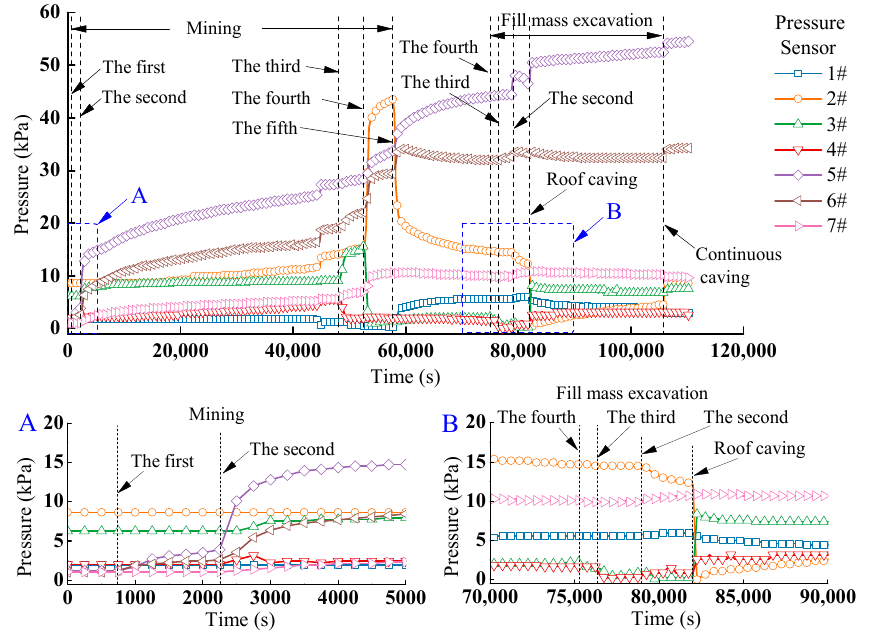
Figure 9. Variation of 1#–7# pressure sensor stress in overlying strata: A , Enlarged view of the stress change in the first and second sublevels of mining; B , Enlarged view of the stress change during fill mass excavation.